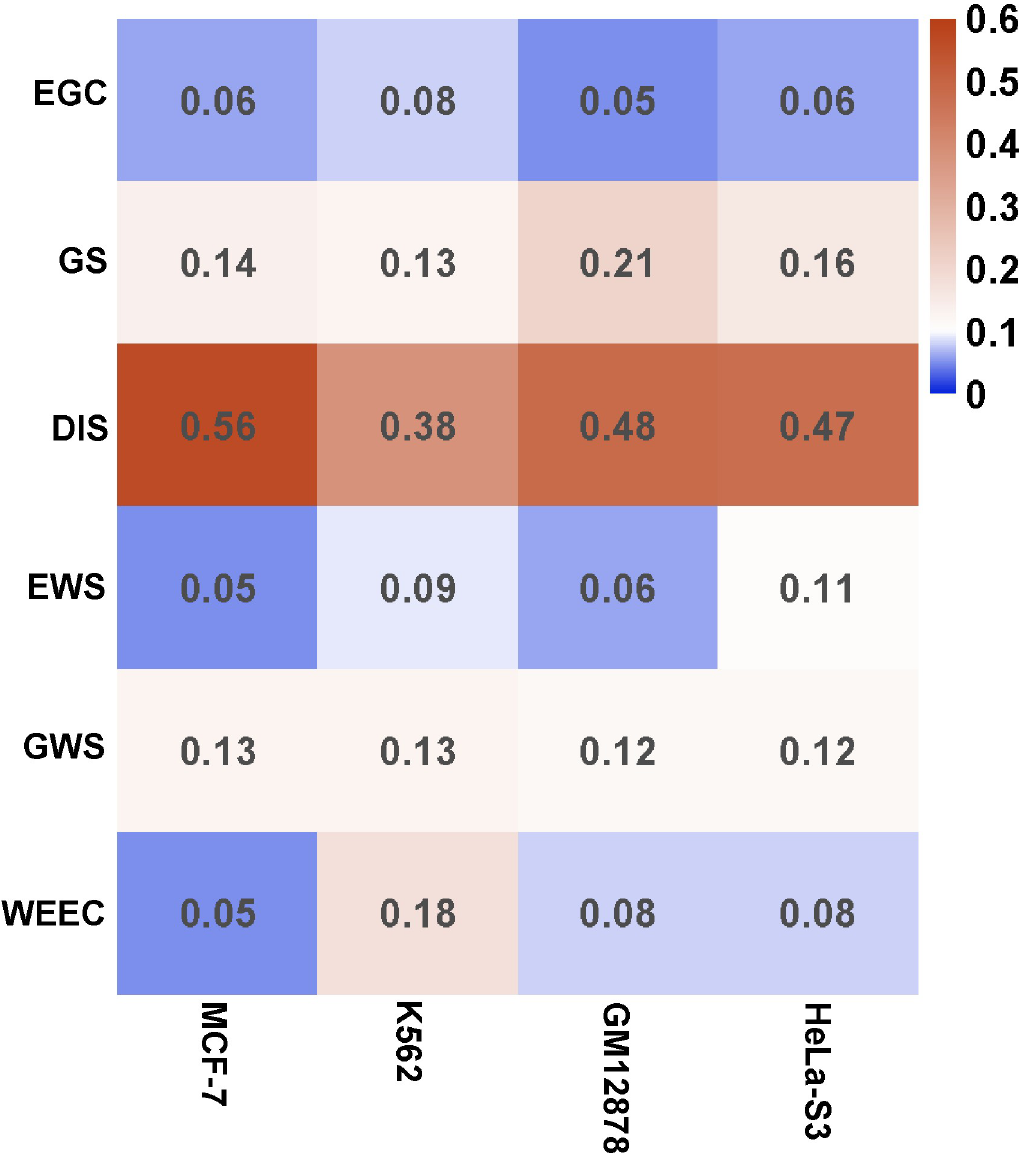
Fig 5. Predictive importance of training features across four common cell lines. The method permuting out-of-bag predictor observation was adopted to evaluate the relative importance of each feature. All features showed good robustness with effective importance ( > = 0.05) across all cell lines. Some features such as DIS contribute > = 38% in all cells. However, some features such as WEEC and EWS have different importance in different cells.